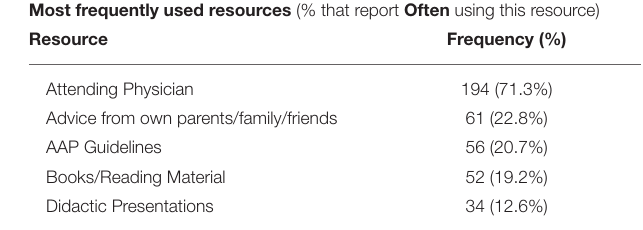
TABLE 7 | Resident parenting questionnaire self-reported frequency of resources used in generating parenting advice. Most frequently used resources (% that report Often using this